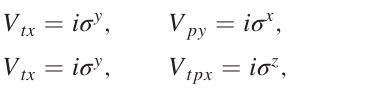
fractionalization using the methods described in Sec. IVA.